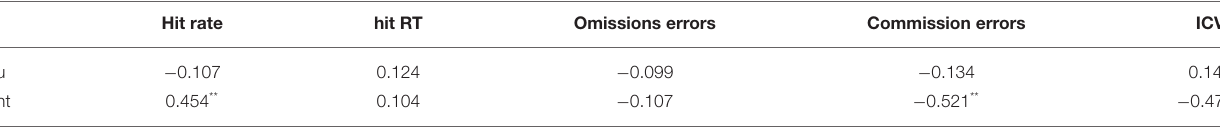
TABLE 1 | Correlation analysis between cognitive control function and blood parameters. Hit rate hit RT Omissions errors Commission errors ICV Glu − 0.107 0.124 − 0.099 − 0.134 0.144 5-ht 0.454 ** 0.104 − 0.107 − 0.521 ** − 0.475 ** ** p <